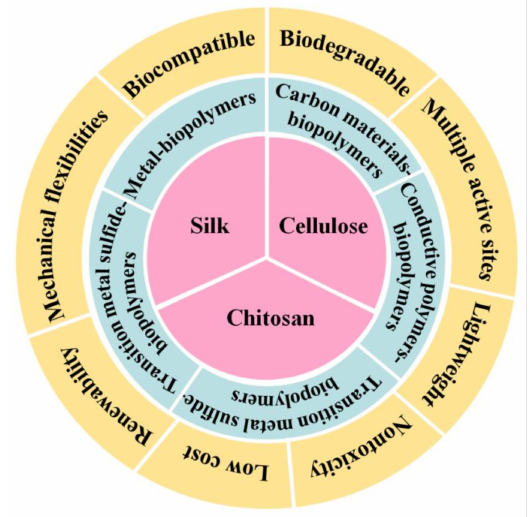
Figure 1. The advantages of three natural biopolymers and their composites for flexible